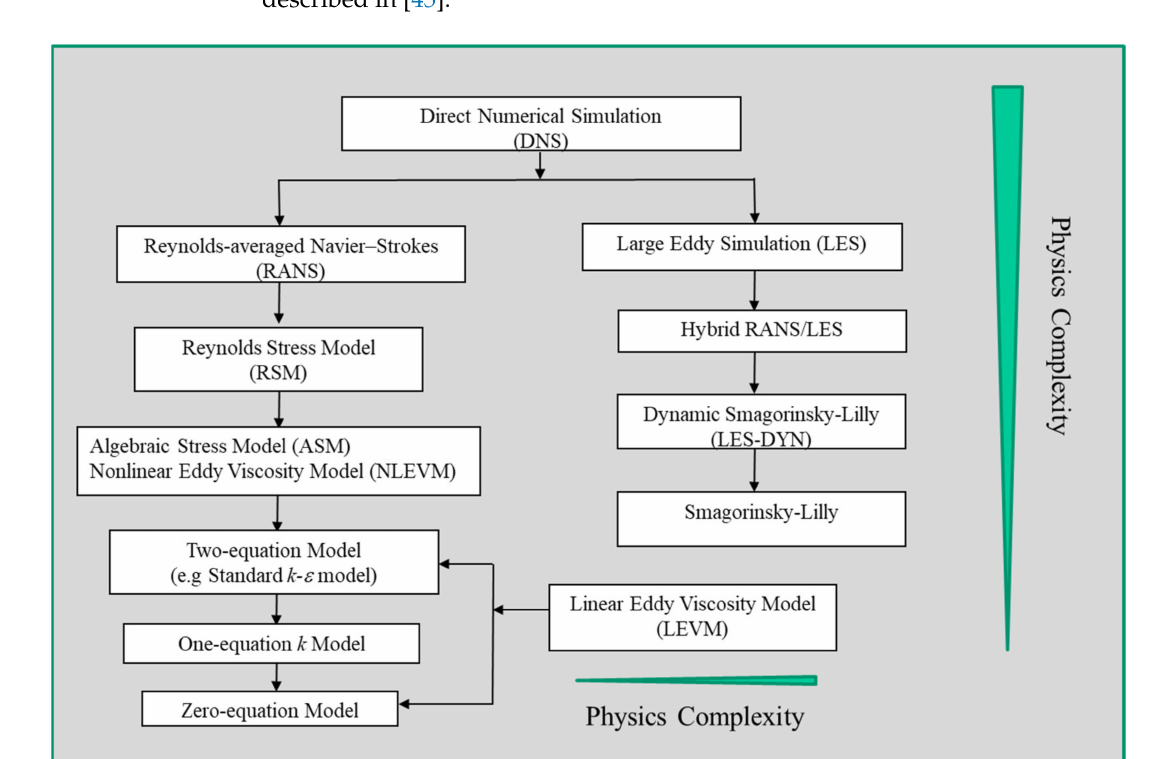
Figure 3. Illustrative hierarchy of the described turbulence models.